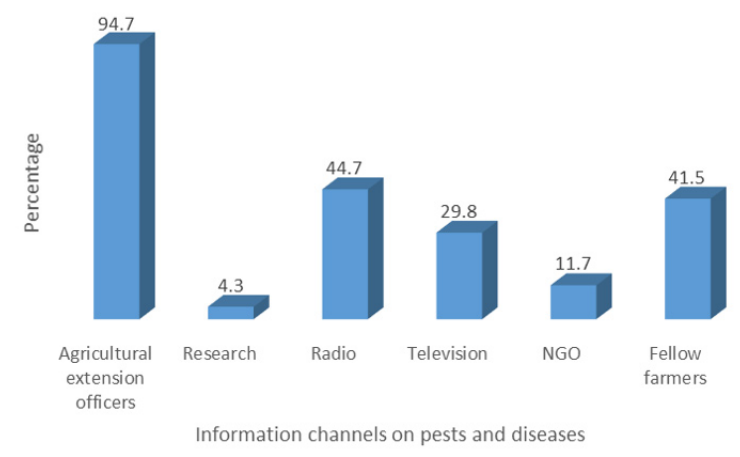
Figure 3. Information channels on crop pests and diseases. NGO, non-governmental